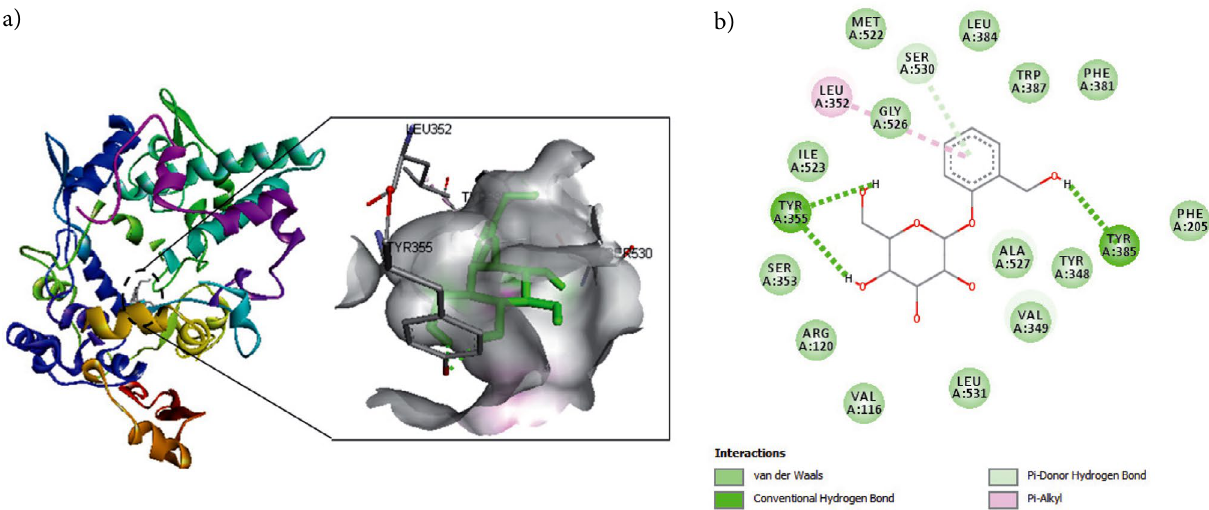
Figure 1. Active site of the COX-1 enzyme with salicin ( A ) 3D view; B ) 2D view)